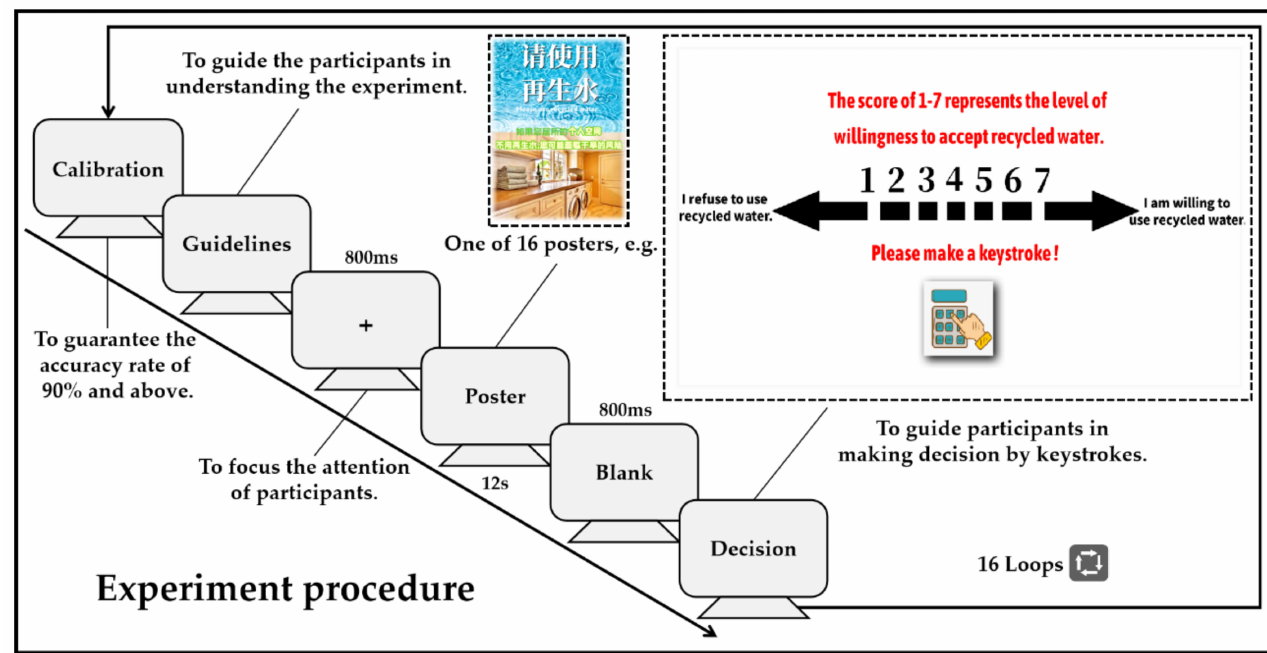
Figure 3. Stimulation Procedure of Eye-tracking, the screen and keyboard, and the options presented to the